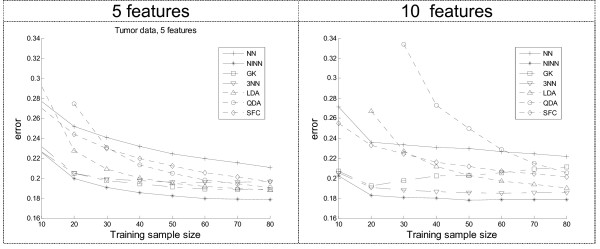
Comparison of various classifiers for patient data.